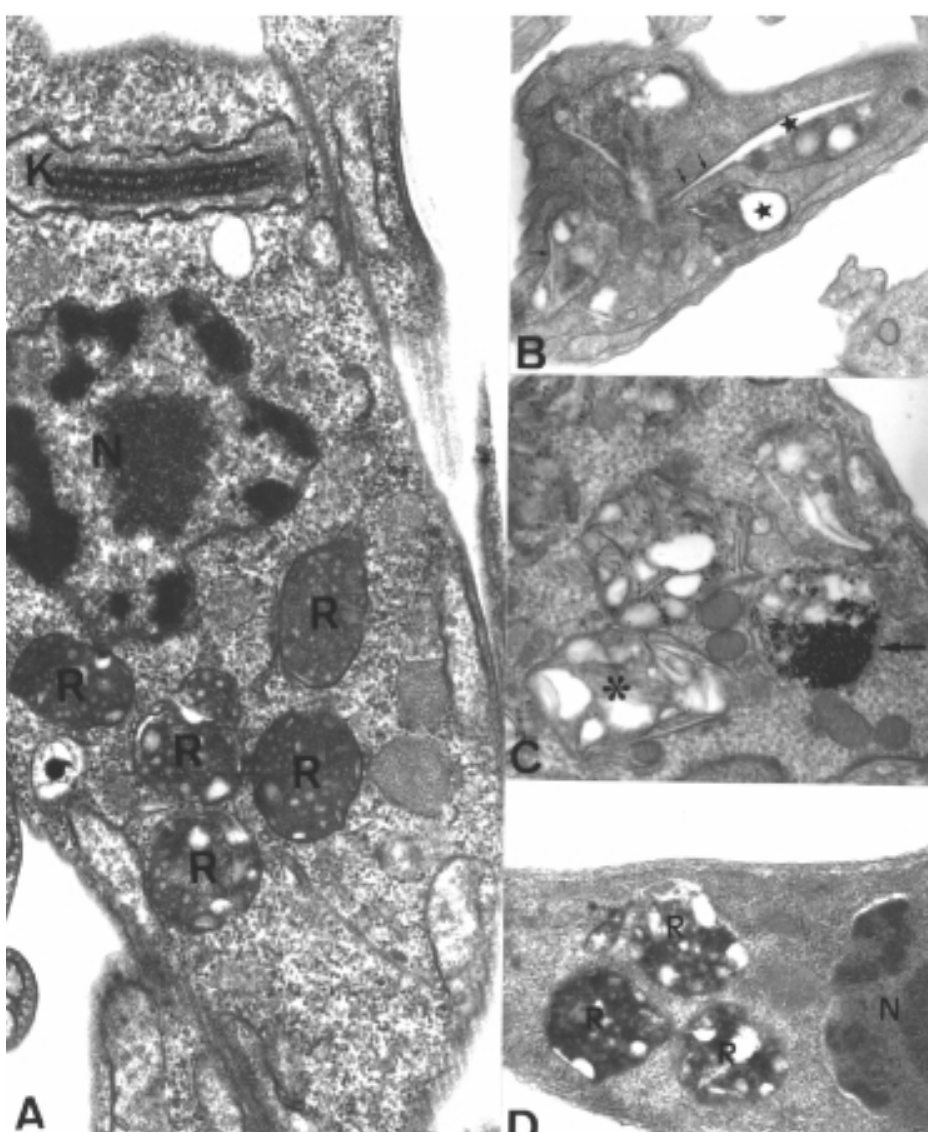
Fig. 3 – Thin sections showing three to five-day old cultured epimastigotes from Y strain (A) and Dm 28 clone (B). In (A), a longitudinal section showing the typical intracellular localization of reservosomes (R), at the posterior portion of the parasite, near the nucleus (N); K, kinetoplast. In (B) reservosomes from Dm28 clone, that under some culture conditions, can depict a very heterogeneous form, containing huge electron-lucent inclusions (stars) that seem to disrupt the organelle (small arrows). (C) Reservosomes (R) from CL Brener epimastigotes that uptaken gold-labeled albumin for 1 hour. In the same parasite, we can findsomereservosomesveryfullofthetracer(arrow), whileotherscontainalmostnone(asterisk). Protein uptake can also be demonstrated by its enzymatic activity (D) : reservosomes are full of exogenously added horseradish peroxidase, subsequently revealed with diaminobenzidine; N, nucleus. (A) X 28,200 (B) X 20,500 (C) X 34,100 (D) X